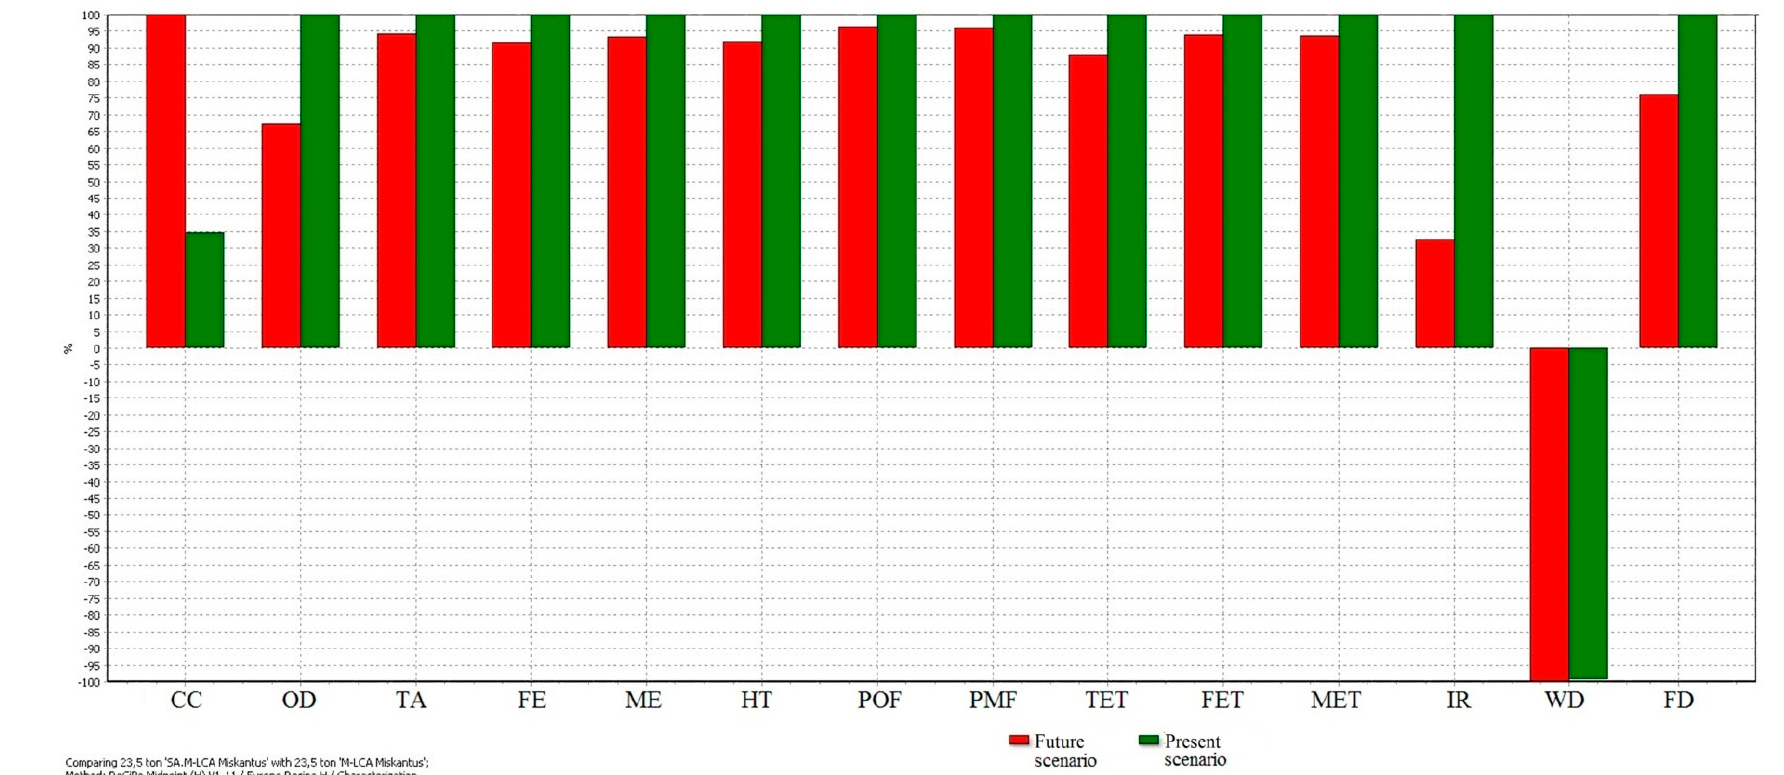
Figure 4. Comparative LCIA for the present scenario and future scenario of Miscanthus